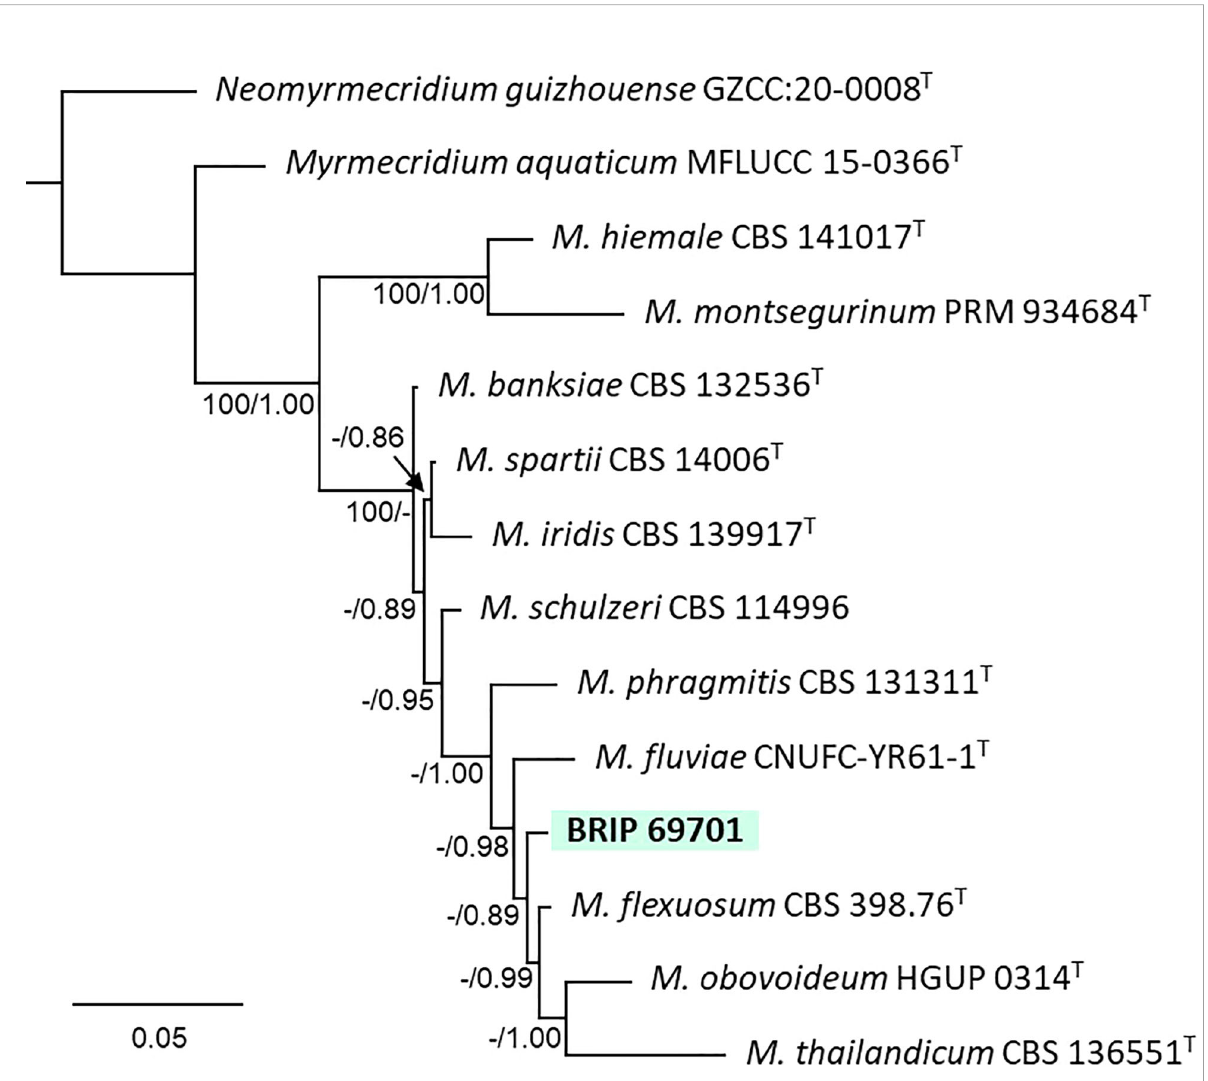
FIGURE 13 Phylogenetic tree inferred from a RAxML analysis based on a concatenated alignment of ITS, LSU, SSU and rpb2 sequences of related species in Myrmecridiaceae (Myrmecridiales). RAxML bootstrap (bs) values greater than 70% and Bayesian posterior probabilities (pp) greater than 0.8 are given at the nodes (bs/pp). In bold font are the isolates from this study, and ex-type strains are indicated with T